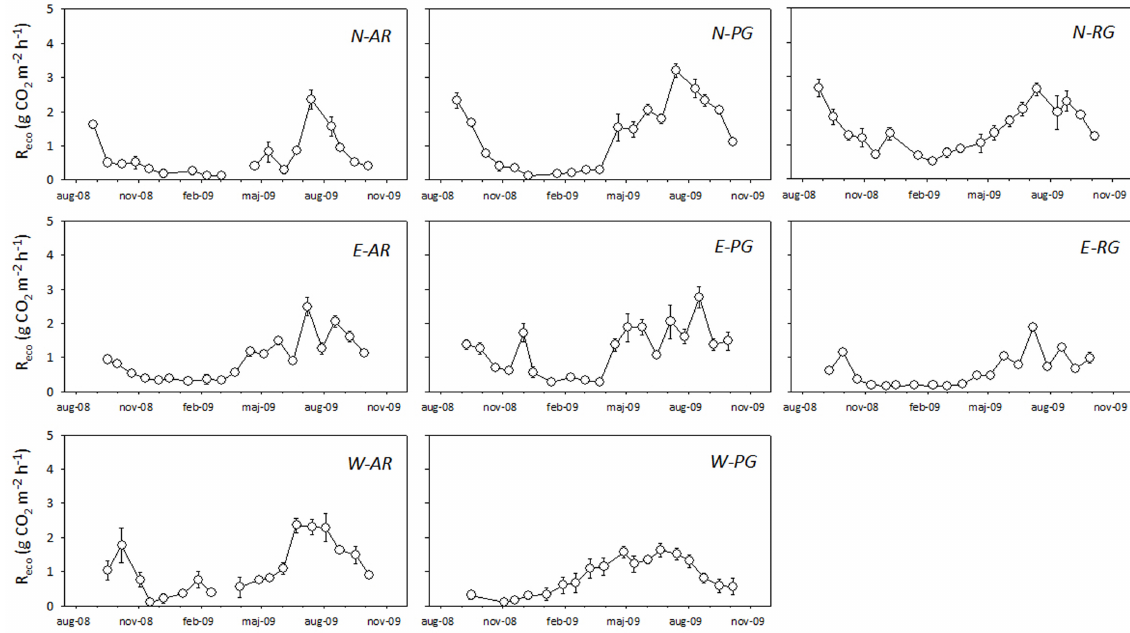
Fig. 8. Seasonal variations in ecosystem respiration ( R eco ) at the eight monitoring sites; for information about site ID, see legend to Fig. 2. One data set from April 2009 at site N-AR was omitted due to unresolved analytical problems. The data represent mean ± standard error ( n =